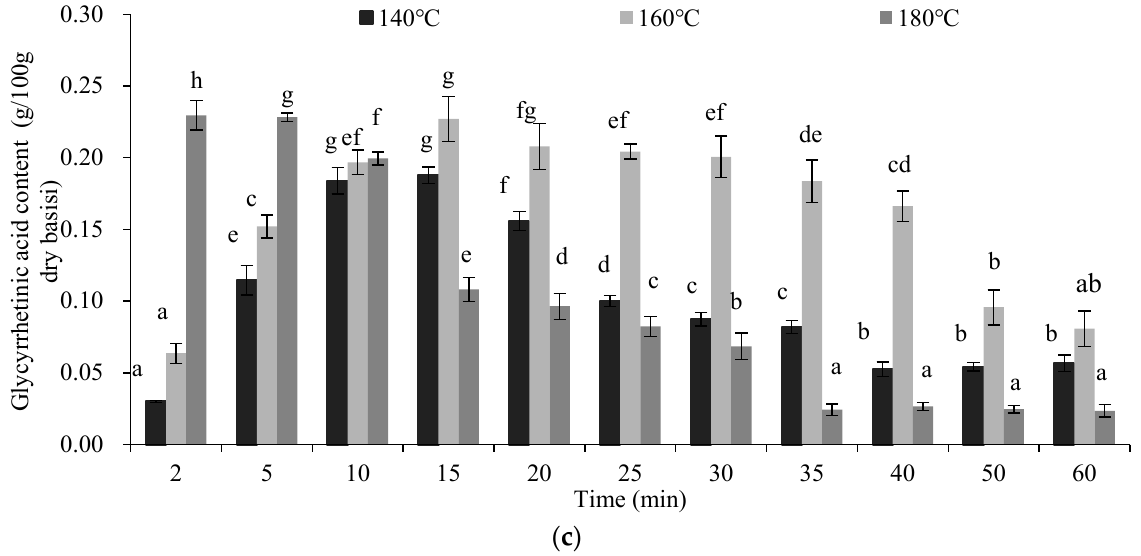
Figure 5. Thermal hydrolysis of glycyrrhizic acid under different temperatures and times, ( a ) the content of glycyrrhizic acid; ( b ) the content of GAMG; ( c ) the content of glycyrrhetinic acid. GAMG: glycyrrhetinic acid 3- O -mono- β -D-glucuronide.The results are expressed as the mean ± standard deviation ( n = 3); different letters indicate significant differences ( p < 0.05) and the same letters indi- cate insignificant differences.